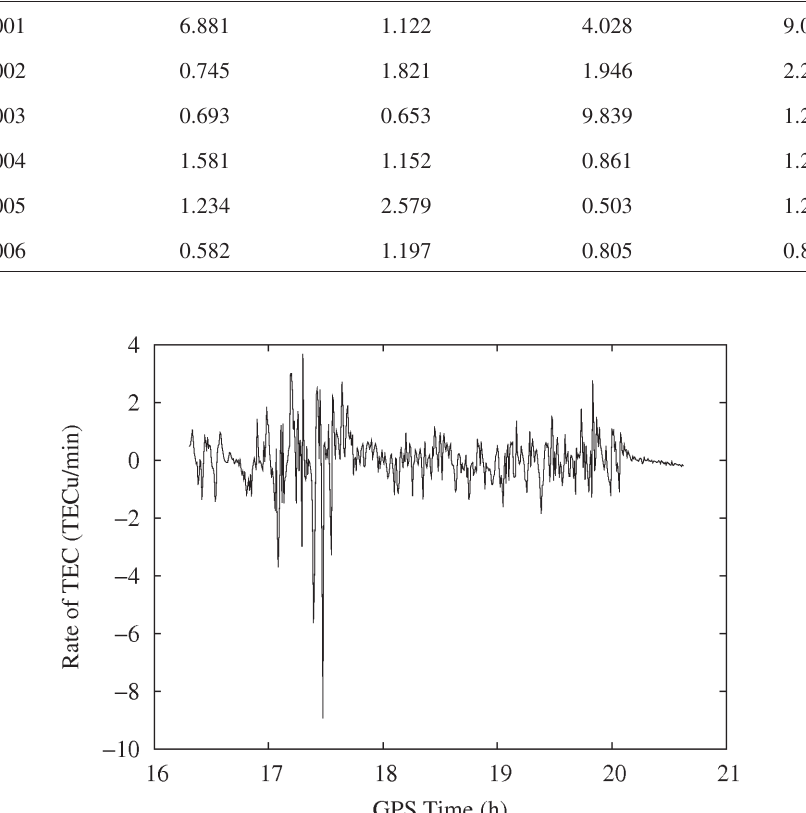
Fig. 7. Ionospheric variability at Brussels on 20th November 2003 (satellite